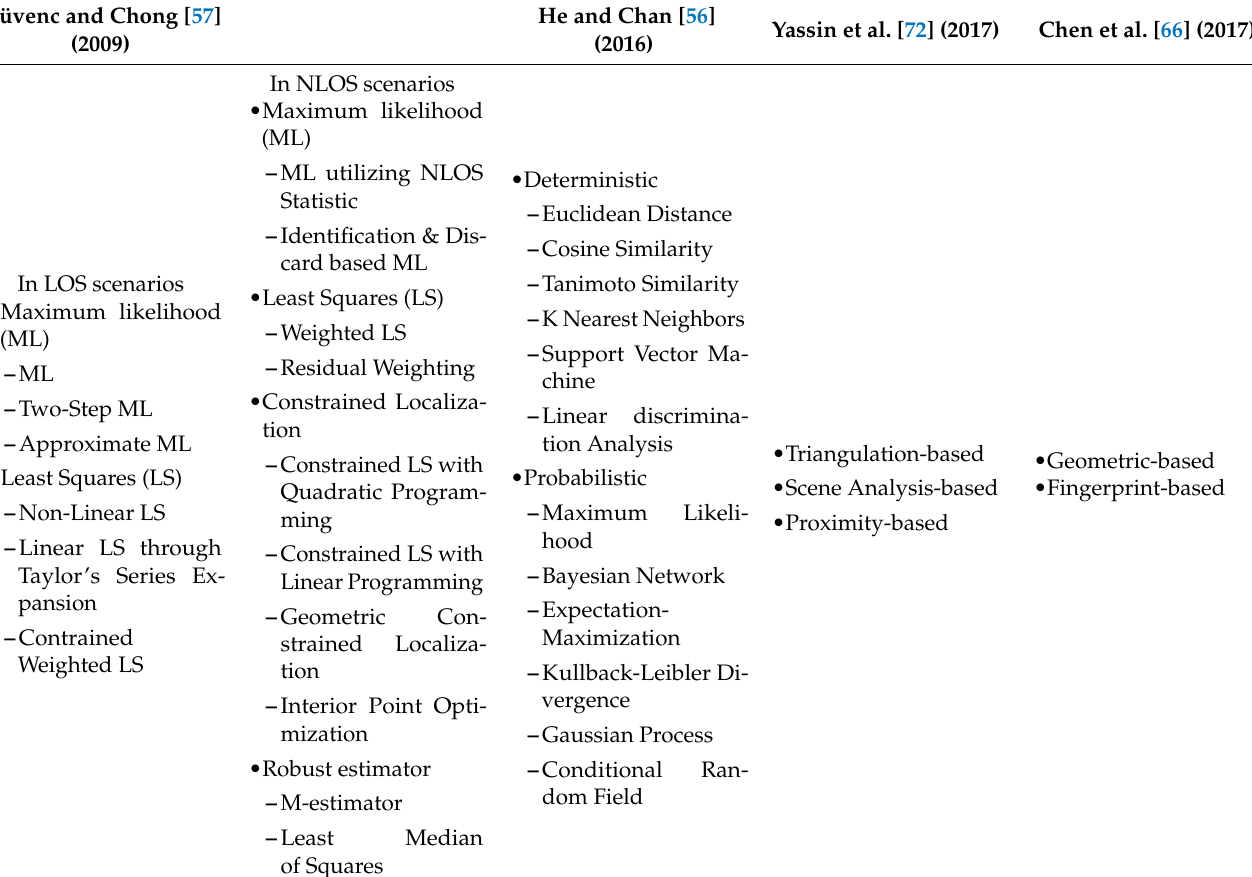
Table 3. Different indoor positioning method classifications